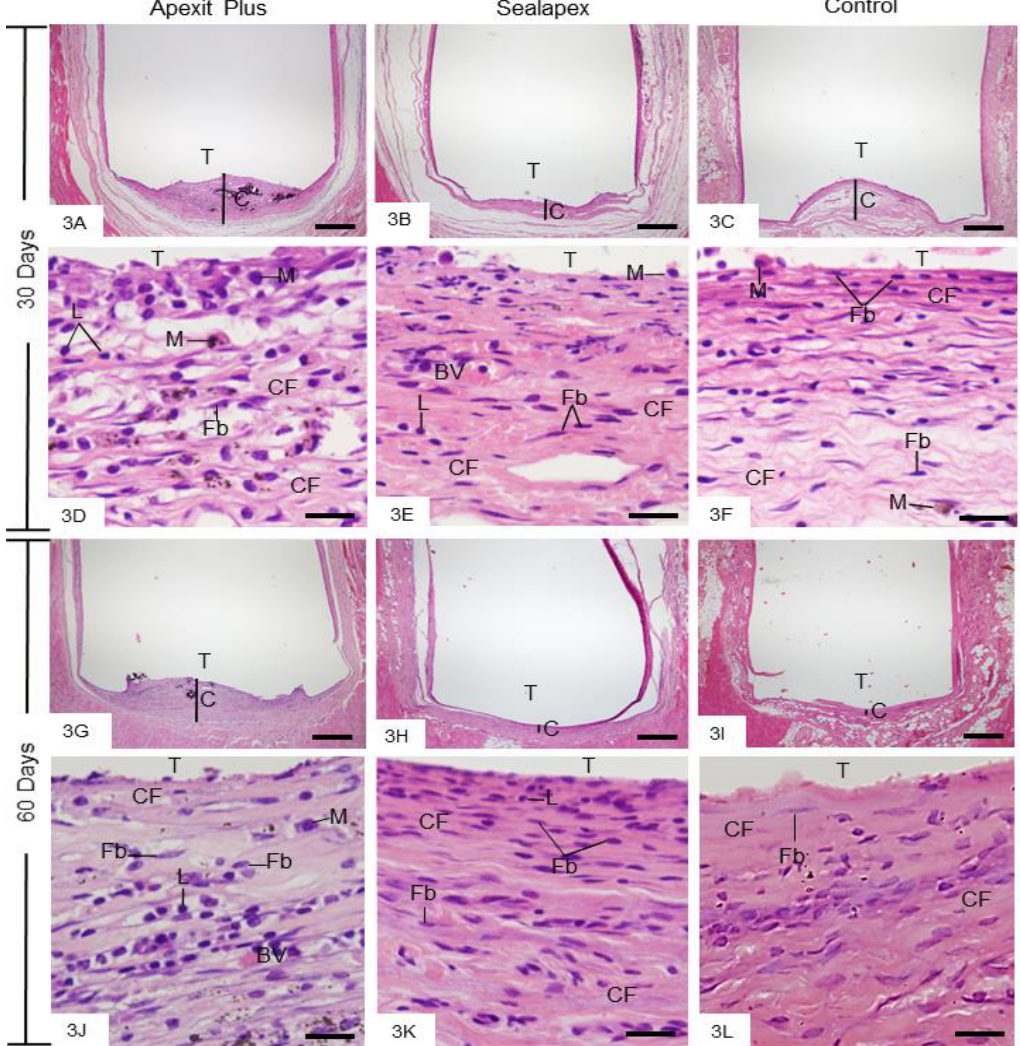
Figure 3. Photomicrographs show portions of capsules surrounding the opening of the tubes (T) at 30 (3 A – F ) and 60 (3 G – L ) days. Low magnifications (3 A – C and 3 G – I ) show thick capsules (C) in Apexit Plus (3 A , G ) in comparison with Sealapex (3 B , H ) and control (3 C , I ) groups. 3 D – F (30 days) and 3 J – L (60 days) High magnifications. 3 D – F Macrophages (M), lymphocytes (L), fibroblasts (Fb), and collagen fibers (CF) are present. 3 J – L The capsules contain numerous fibroblasts (Fb) and bundles of collagen fibers (CF). M, macrophages; L, lymphocytes; BV, blood vessel profile. H&E. Bars: 500 µ m (3 A – C and 3 H – J ) and 20 µ m (3 D – F and 3 J – L